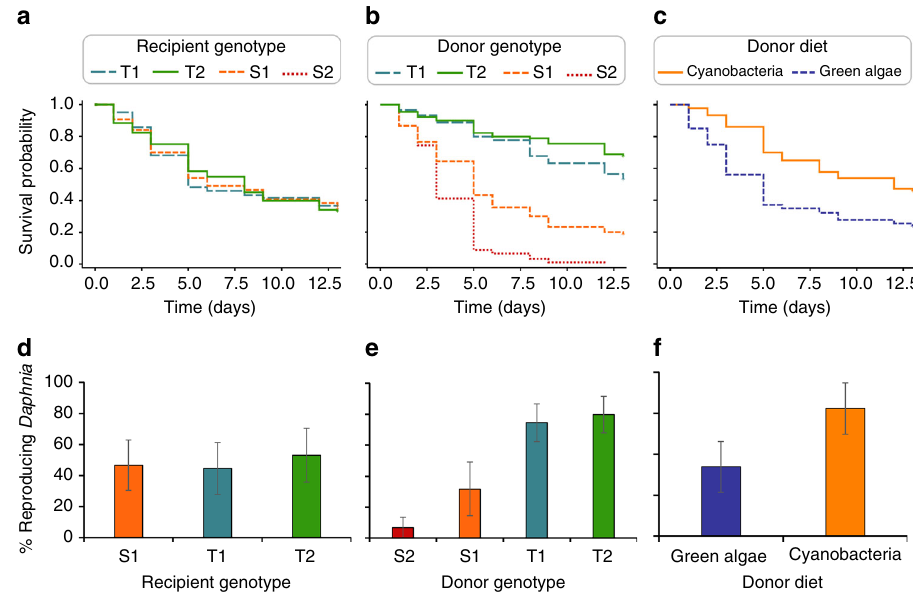
Fig. 3 Survival and reproduction upon cyanobacterial exposure in recipient Daphnia that received a gut microbiota transplant. a Average survival of recipient Daphnia , grouped by recipient genotype. The effect of recipient genotype on recipient Daphnia survival was not statistically signi fi cant ( p = 0.64). b Average survival of recipient Daphnia , grouped by donor genotype. Survival in recipient Daphnia was signi fi cantly affected by the donor genotype ( p < 0.0001), with higher survival rates in recipient Daphnia receiving the gut microbiota from tolerant donor genotypes ( p = 0.02 for T1 – T2 pairwise comparison and p < 0.0001 for all other pairwise comparisons). c Average survival of recipient Daphnia , grouped by donor diet. A pre-exposure of donors to toxic cyanobacteria signi fi cantly increased survival in recipients, compared to a pre-exposure to green algae ( p < 0.0001). d Average proportion of reproducing Daphnia , grouped by recipient genotype. The effect of recipient genotype on Daphnia reproduction was not statistically signi fi cant ( p = 0.15). e Average proportion of reproducing Daphnia , grouped by donor genotype. The proportion of reproducing recipient Daphnia was signi fi cantly affected by the donor genotype ( p < 0.0001), and was higher in recipient Daphnia receiving the gut microbiota from tolerant donor genotypes ( p < 0.0001 for T1 – S1 , T1 – S2 , T2 – S1 , and T2 – S2 pairwise comparisons; p = 0.058 and 0.14 for S1 – S2 and T1 – T2 pairwise comparisons, respectively). f Average proportion of reproducing Daphnia , grouped by donor diet. A pre-exposure of donors to toxic cyanobacteria signi fi cantly increased the proportion of reproducing individuals in recipients, compared to a pre-exposure to green algae ( p < 0.0001). p values were obtained from a Cox model for survival, and from a logistic regression for reproduction. Survival and reproduction data were obtained from the same individuals. Total sample size was n = 360 (4 donor genotypes × 2